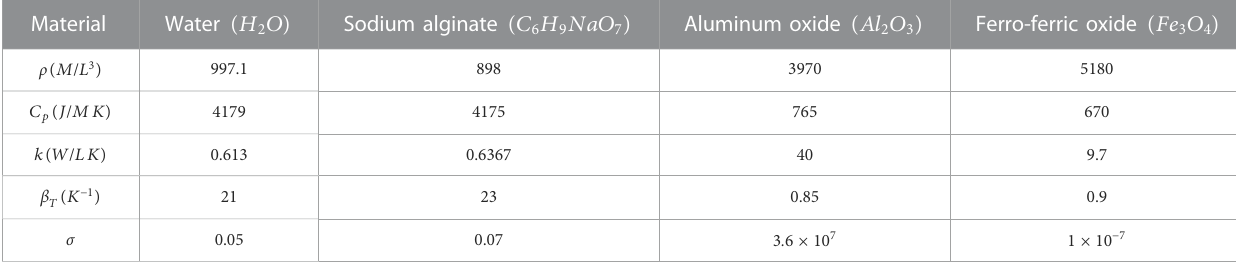
TABLE 1 Thermal characteristics of base fl uids and nanoparticles (Raza et al., 2022; Zhang et al., 2022). Material